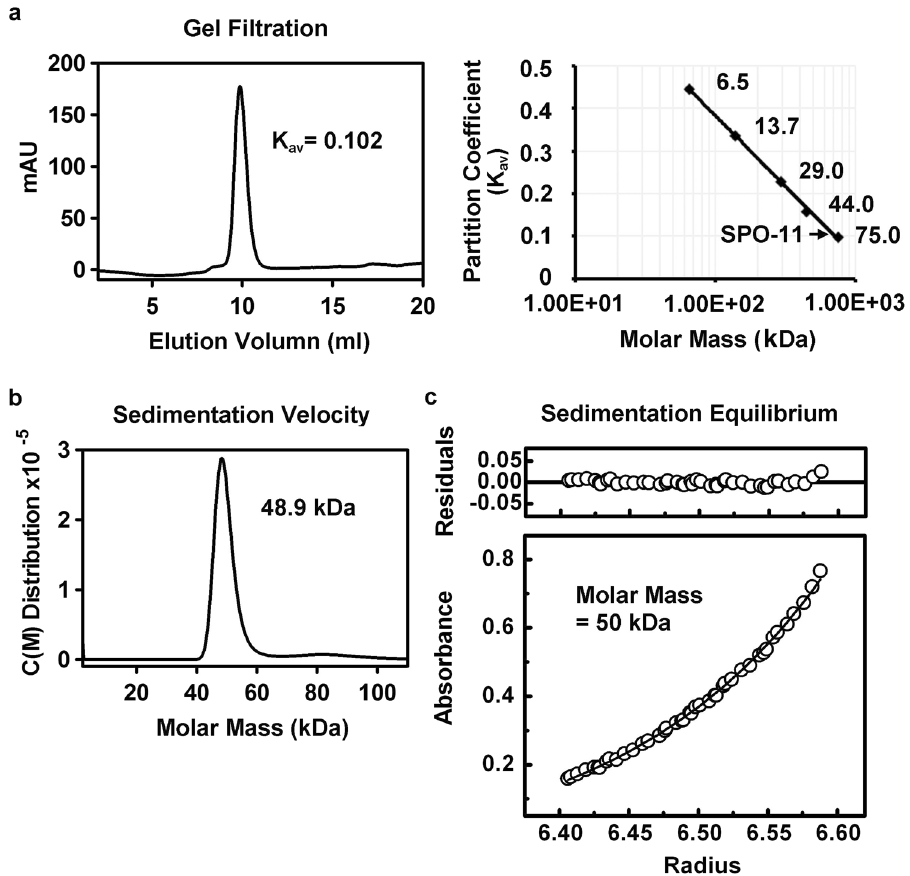
Figure 2. C. elegans SPO-11 is monomeric in solution. ( a ) Purified SPO-11 was analyzed in a Superdex 75 10/300 GL column. A plot of the partition coefficient (K av ) versus molar mass with size standards was used to calculate the apparent molecular weight of SPO-11. ( b ) Analytical ultracentrifugation (AUC) with sedimentation velocity analysis of SPO-11. The experimental data were analyzed by the Sedfit program (version 12.1), which yielded an estimated molecular mass of 48.9 kDa. ( c ) Sedimentation equilibrium analysis of recombinant SPO-11. The average of molecular mass was estimated to be 50 kDa. The upper part of the figure shows the residual difference between experimental and fitted values by the standard